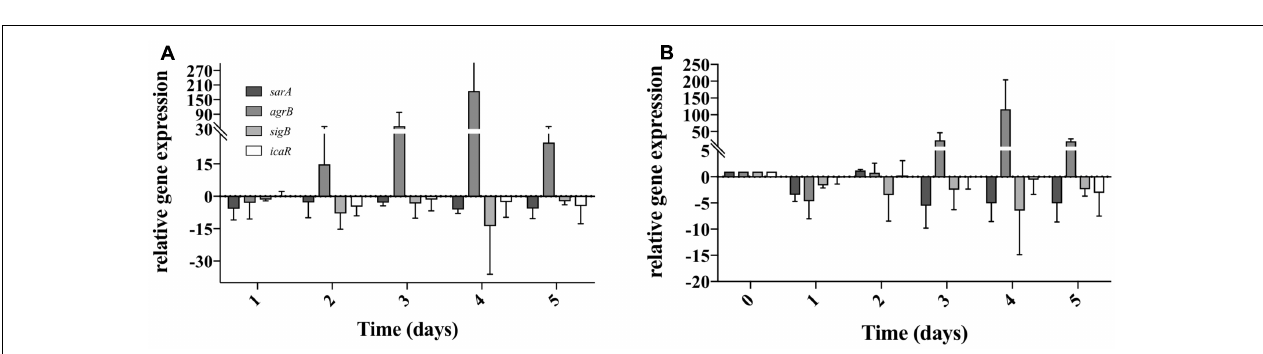
FIGURE 5 | Staphylococcus aureus QS gene expression when co-cultured with P. aeruginosa on tube reactors. S. aureus biofilms were cultured in tube reactors for a period of 5 days previous to the introduction of P. aeruginosa . Once P. aeruginosa aeruginosa was introduced (day 0), samples were taken at 24 h intervals for a period of 120 h. (A) relative expression of S. aureus QS genes in dual-species biofilms compared to single species biofilms. (B) Relative expression of S. aureus single species biofilms compared to time 0. Changes of relative expression were considered significant when a twofold change was present.